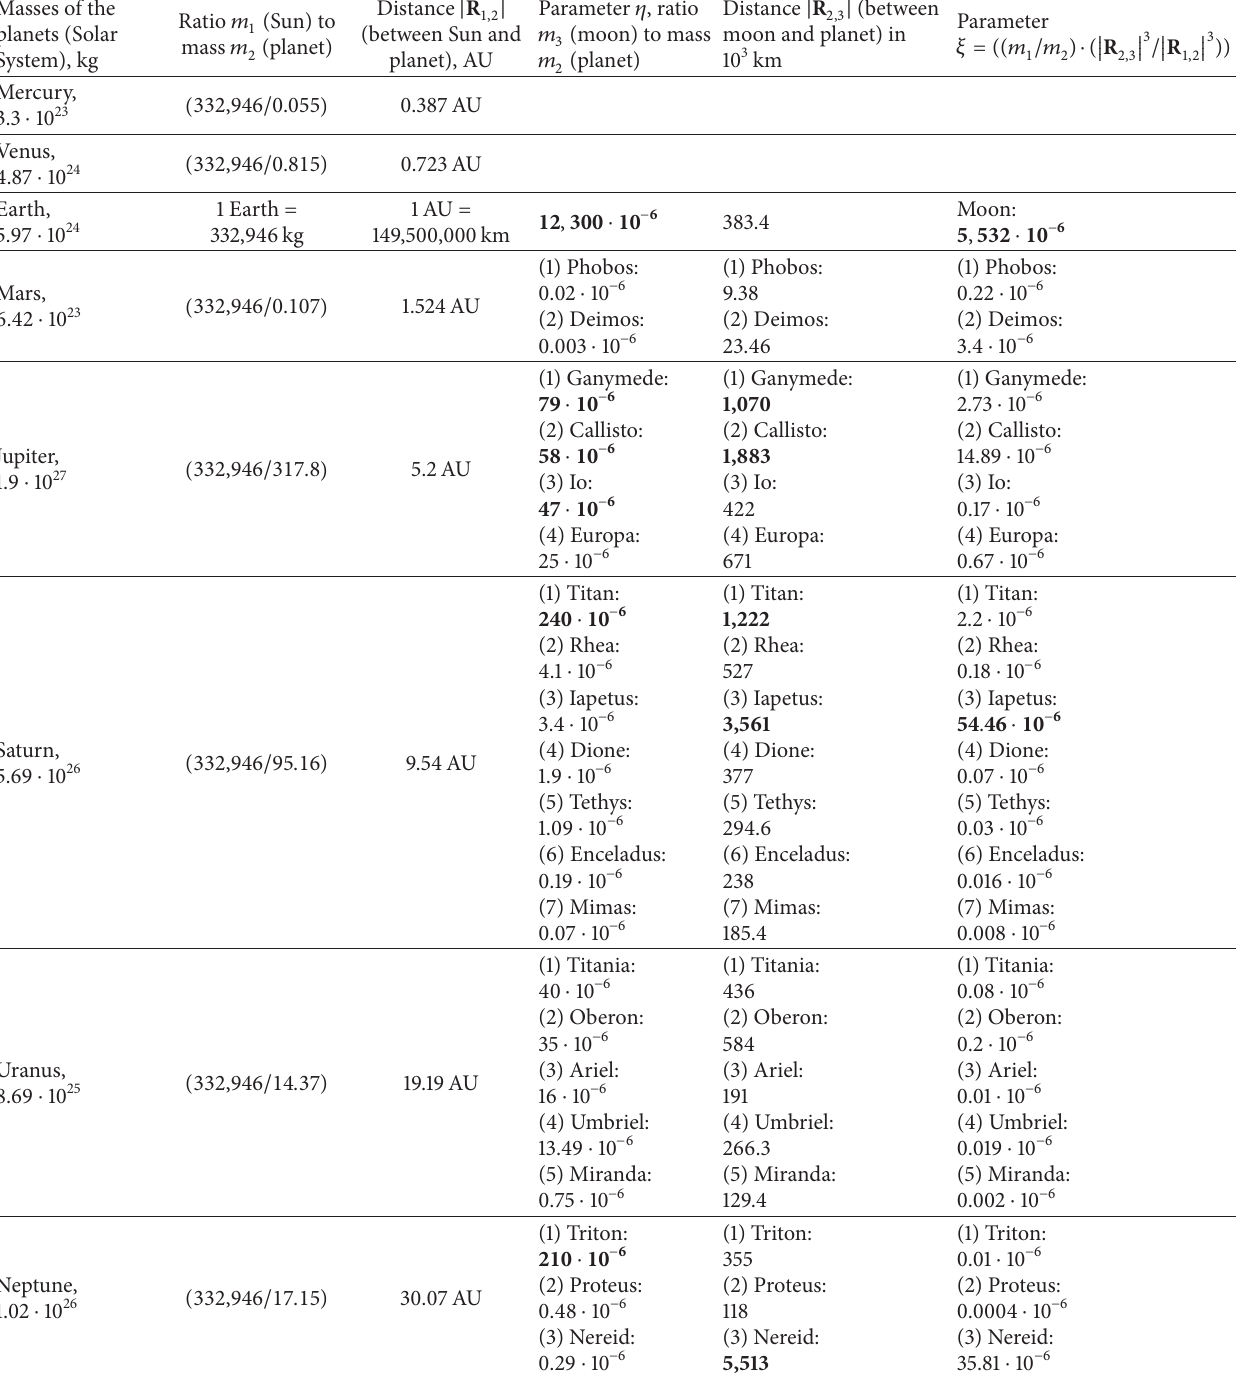
Table 1: Comparison of the averaged parameters of the moons in Solar